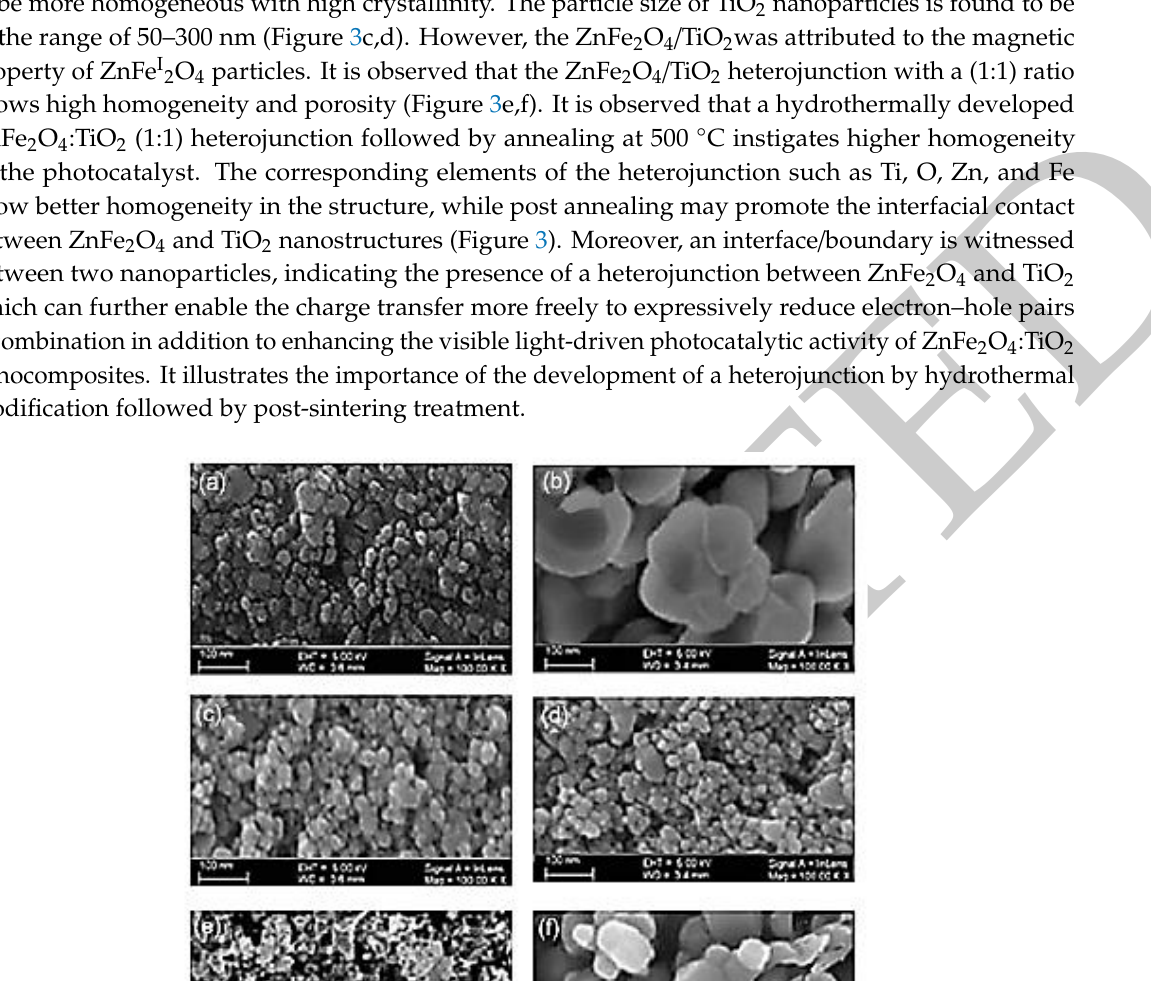
Figure 3. Images ( a , b ) ZnFe 2 O 4 , ( c , d ), and ( e , f ) ZnFe 2 O 4 :TiO 2 (1:1).